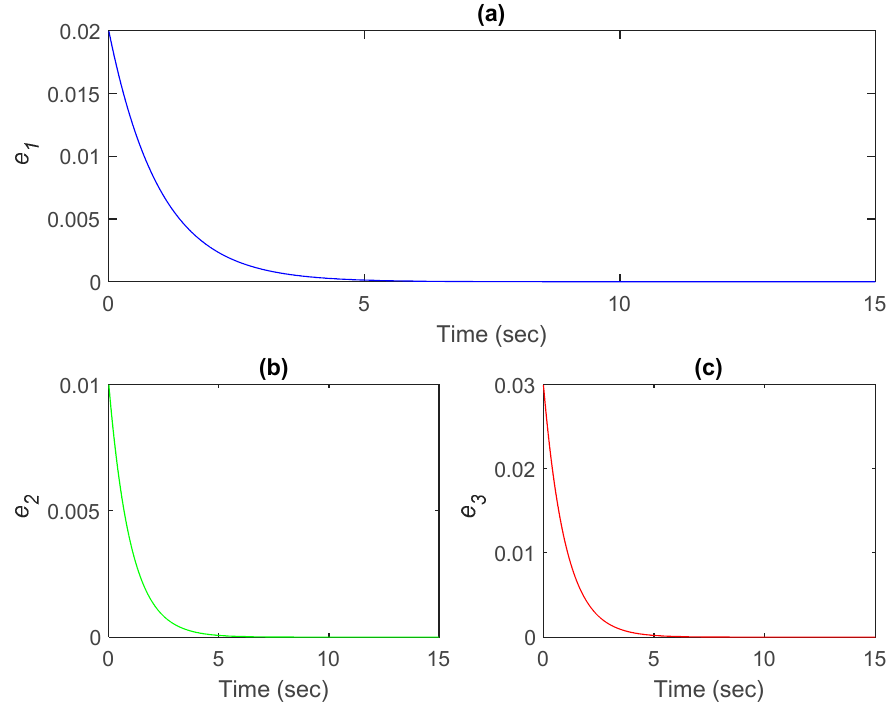
Figure 11. Dynamics of synchronization errors: ( a ) e 1 = v 1 − y 1 , ( b ) e 2 = v 2 − y 2 , and ( c ) e 3 = v 3 − y 3 .